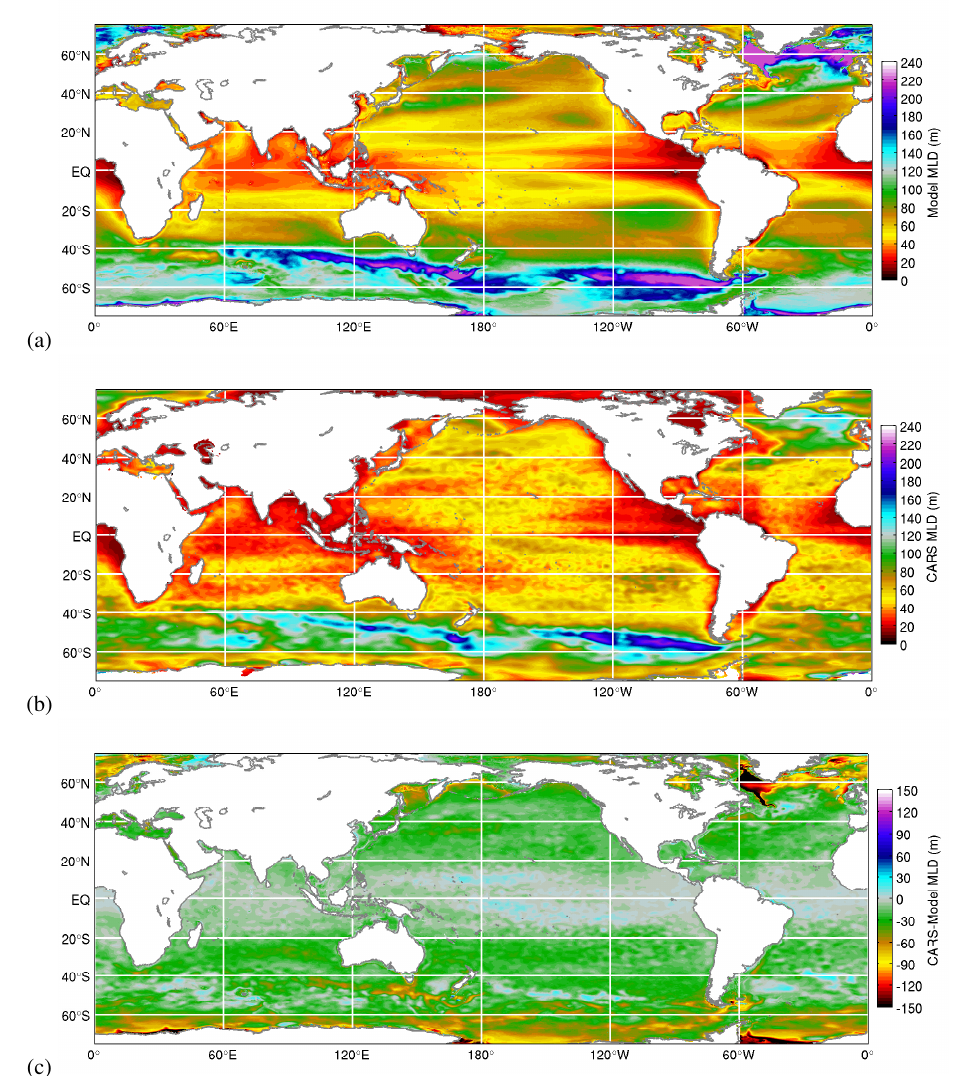
Fig. 2. Comparison of the time-averaged MLD (m) from the (a) model, (b) CARS (Ridgway and Dunn, 2003), and (c) the difference between the CARS and model MLD field. The model MLD is calculated from daily means using the MLD definition described by de Boyer Montegut et al. (2004).